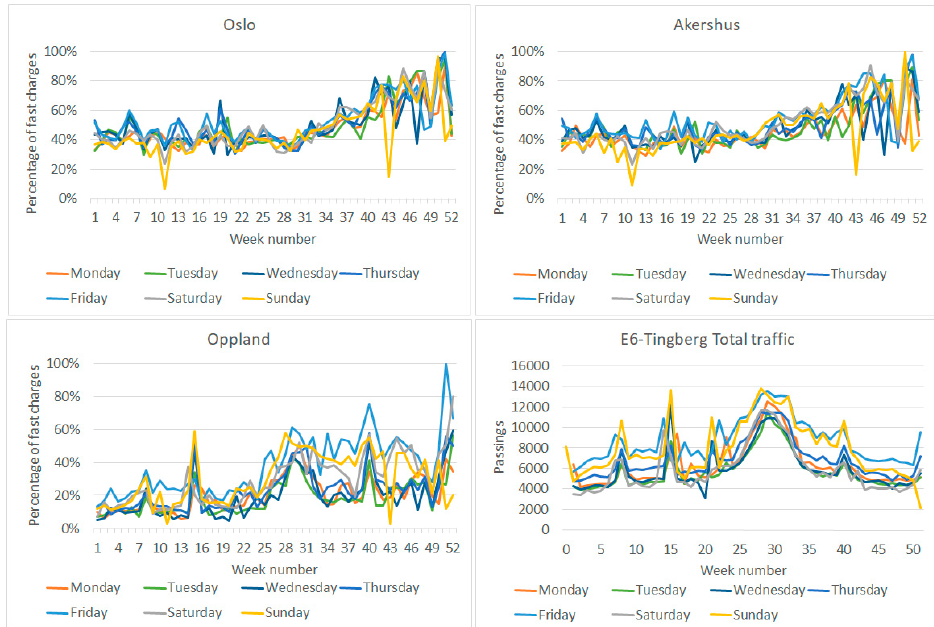
Figure 8. Development of charge volume over 2017 for three Counties. Max value over the year was set to 100%. Dataset 1. Total Light Duty Vehicle traffic flow (number of passenger cars and light commercial vehicles) through a toll gate in the middle of Oppland County 2017. Source of toll road data: Toll road company [4,41].